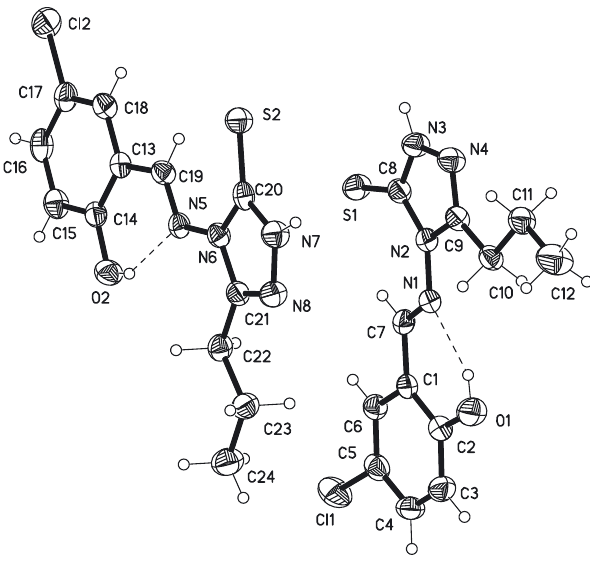
Table  : Data collection and